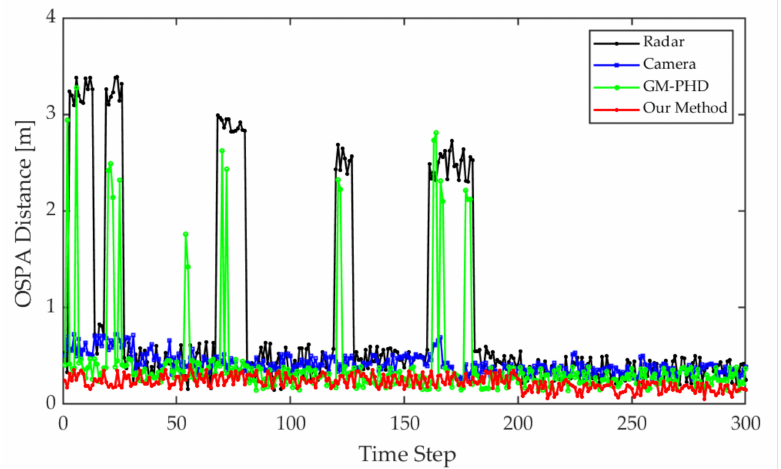
Figure 9. Optimal Sub-Pattern Assignment (OSPA) distance comparison for each tracking